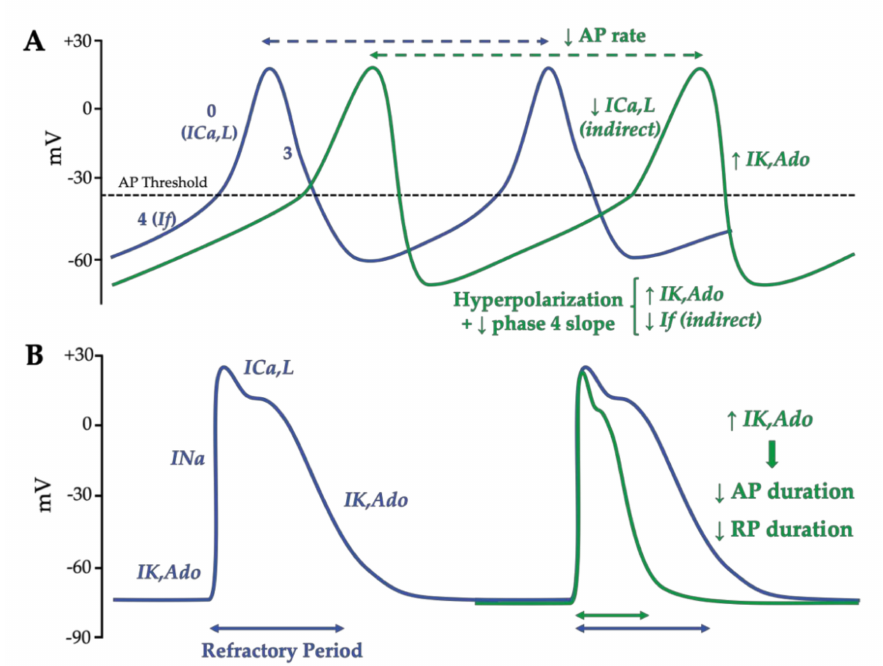
Figure 4. Illustrations of the effects of adenosine on action potential in a sinoatrial cell ( A ) and atrial cardiomyocyte ( B ). In a sinoatrial node, adenosine increases the outward IK,Ado current, which induces hyperpolarization and reduces the slope of the diastolic depolarization. Complementarily, adenosine reduces indirectly the inward Na + pacemaker current (If) and the inward Ca 2+ -dependent depolarization through L-type Ca 2+ channels (ICa,L). Adenosine incudes negative chronotropy. On an atrial working myocardium, adenosine increases the outward K + current (IK,Ado) and shortens the action potential duration and the refractoriness, thereby adenosine can reduce atrial contractil- ity. Dotted arrows correspond to the corresponding RR intervals. Solid arrows correspond to the corresponding action potential refractory